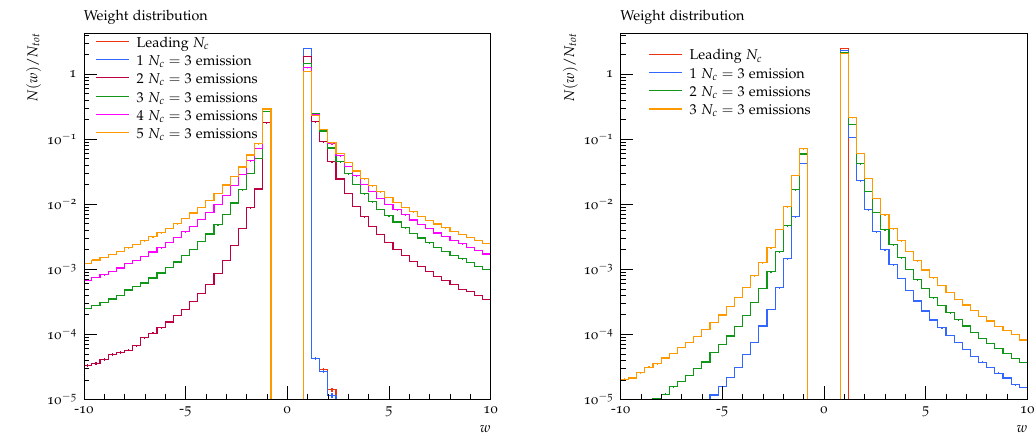
Figure 1 . Weight distribution for e + e (cid:0) (left) and pp collisions (right) depending on the number of N c = 3 emissions allowed. All generated events are used in these plots, i.e., no further analysis cut is applied.